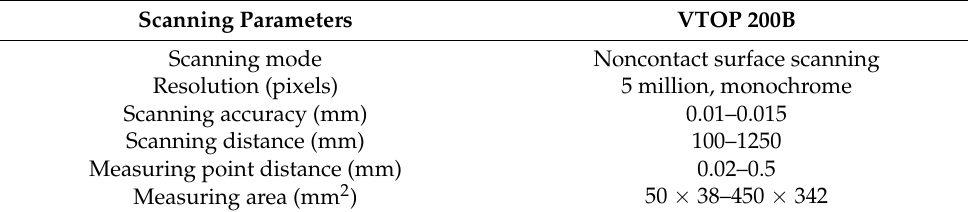
Table 3. Three-dimensional scanner VTOP 200B